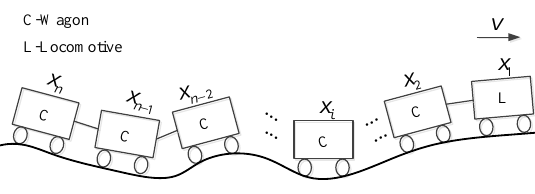
Figure 4. Multi-particle model of a freight train.